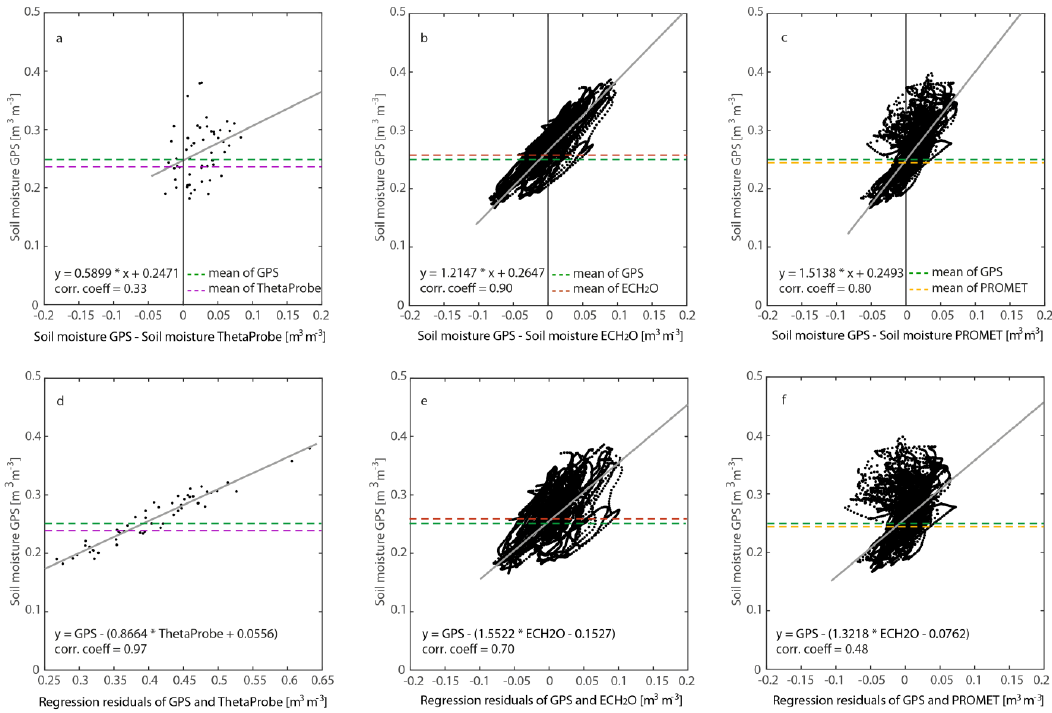
Figure 6. Comparison of soil moisture derived by GPS with the difference between ( a ) GPS and ThetaProbe; ( b ) GPS and ECH 2 O; and ( c ) between GPS and PROMET as well as with the regression residuals between ( d ) GPS and ThetaProbe; ( e ) GPS and ECH 2 O; and ( f ) between GPS and PROMET.